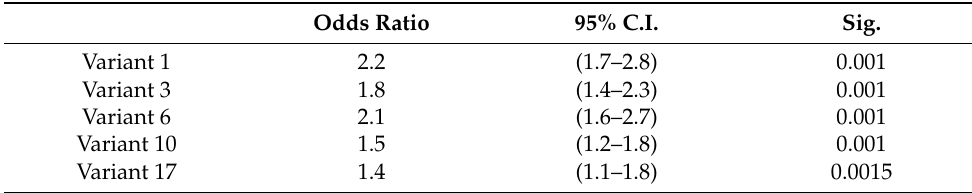
Table 2. Shape variants associated with ACL